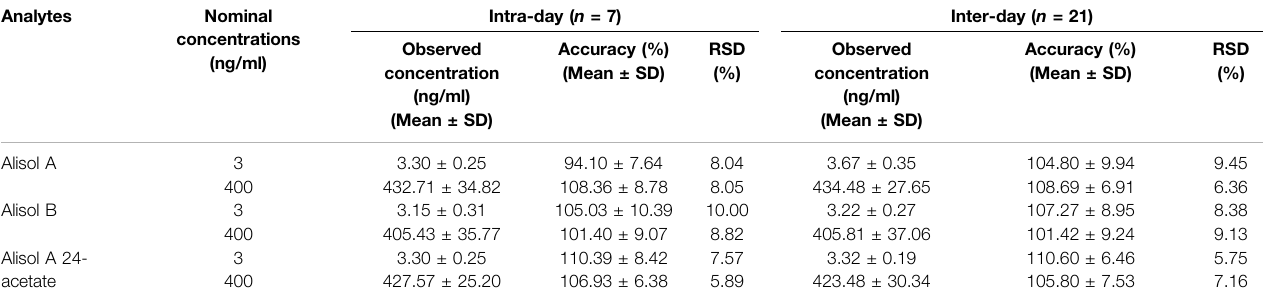
TABLE 2 | Accuracy and precision of QC samples.